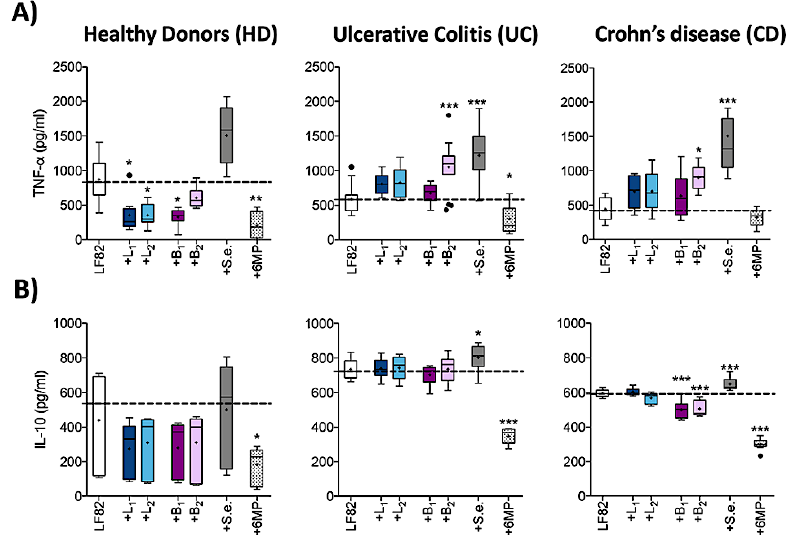
Figure 3. E ff ects of probiotic strains on cytokine secretion by MDM derived from HD, UC and CD patients infected with AIEC-LF82 strain. ( A ) TNF- α and ( B ) IL-10 secretion by MDM derived from HD, UC patients or CD patients after 8 h of infection with AIEC-LF82 alone or in the presence of Lactobacillus strains ( + L 1 , + L 2 ) or Bifidobacterium strains ( + B 1 , + B 2 ) or S. epidermidis ATCC-155 ( + S.e.), at 1:1 ratio or in the presence of 6MP (2 µ g / mL) was quantified by ELISA. Dot lines (—) represent the median values for cytokine secretion of MDM infected with LF82 alone. Data are represented as explained in Figure 1. Statistical significance for each condition compared to MDM infected with LF82 alone was reported (* p < 0.05, ** p < 0.01, *** p < 0.001).